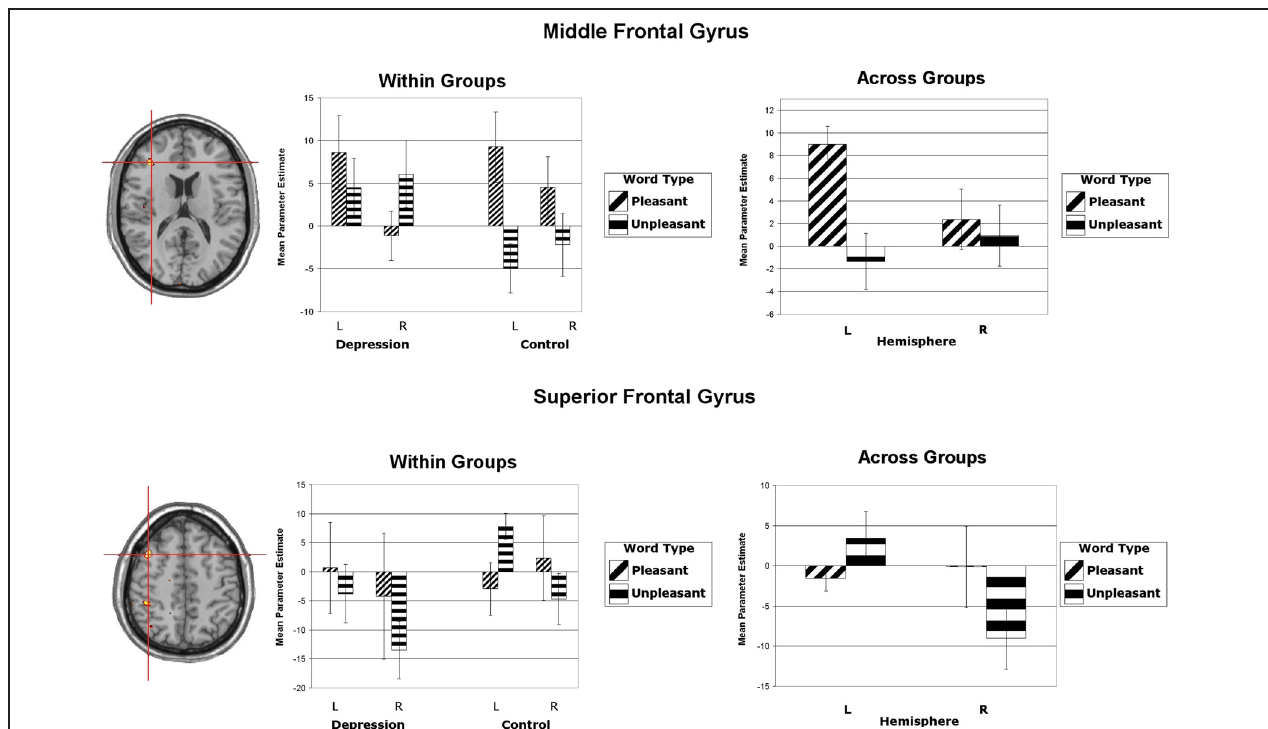
FIGURE 2 | Upper panels: Region yielding a Valence × Hemisphere interaction in middle frontal gyrus of dorsolateral prefrontal cortex. The left panel shows the significant cluster in an axial slice at Talairach z = 16. (Although the center of this cluster was inferior to that illustrated in Figure 1 , the means showed the same pattern.) Lower panels: Region yielding a Valence × Hemisphere interaction in superior frontal gyrus of dorsolateral prefrontal cortex. The left panel shows the significant cluster in an axial slice